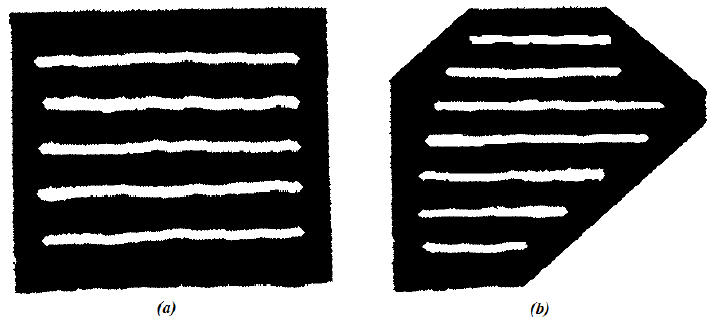
Figure 8. The vineyards scenarios in 2D: ( a ) flat rectangle, ( b ). tilted hexagon.